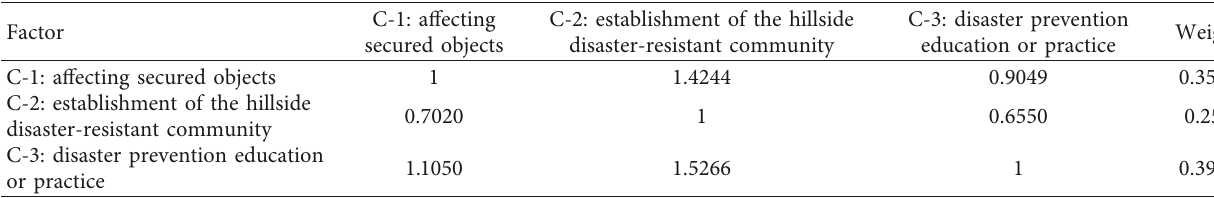
Table 8: Relative importance of factors for “C: vulnerability.”